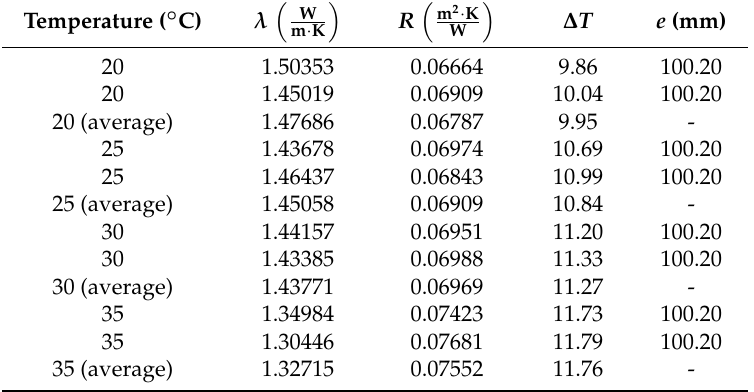
Table A4. Experimental data obtained for thermal conductivity determination (SCC